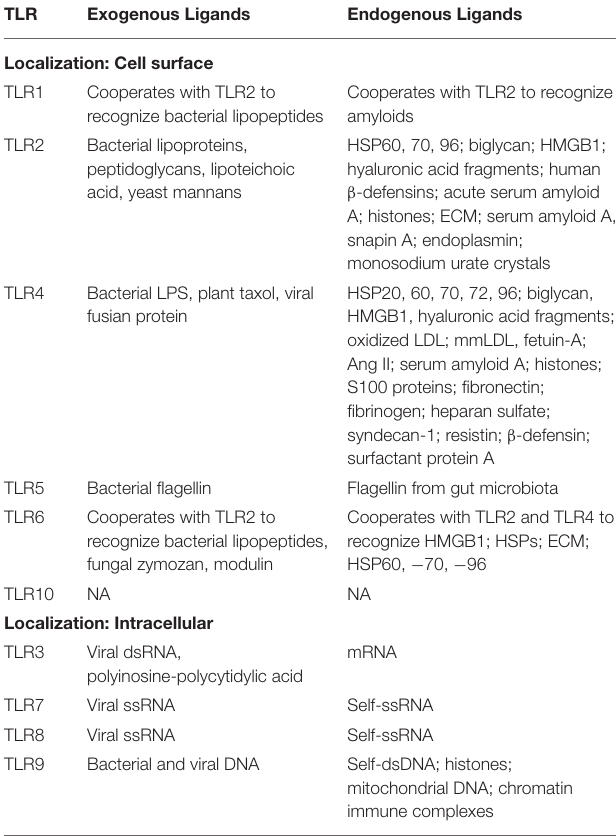
TABLE 1 | TLRs and their